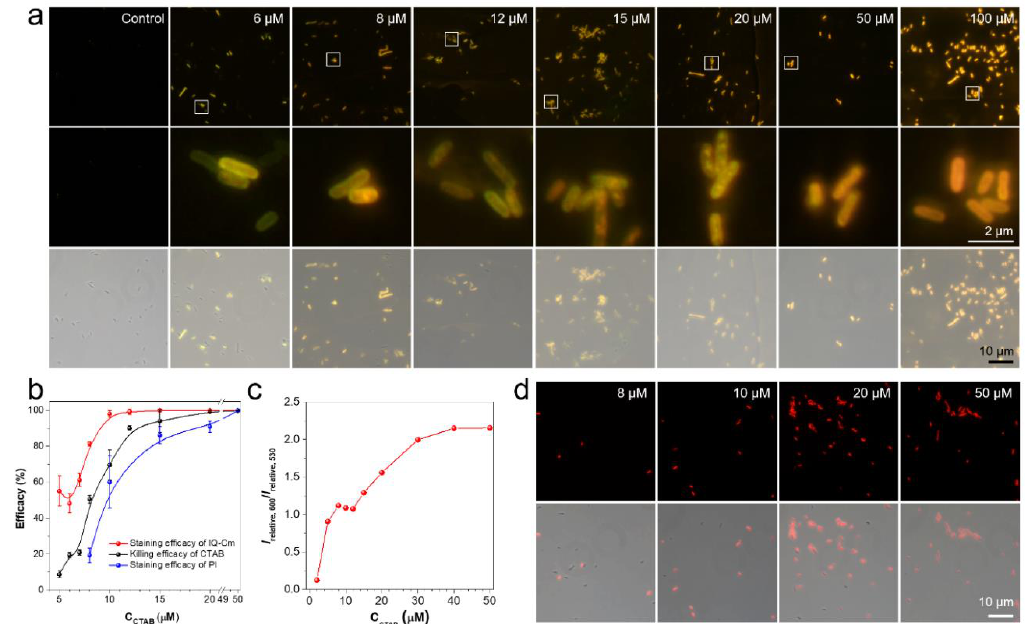
Figure 3. Visualization of the activity of antimicrobials under different concentrations. ( a ) Fluores- cence images and merged images of E. coli treated by different concentrations of CTAB for 30 min and then stained by 10 µ M of IQ-Cm for 10 min (The second row of images are the enlarged images of chosen white square areas in the first row of images). Excitation filter = 460–490 nm, dichroic mirror = 505 nm, emission filter = 515 nm long pass. ( b ) The plots of the staining efficacy of IQ-Cm and PI for E. coli and the antibacterial activity of CTAB against E. coli versus the concentration of CTAB. ( c ) The plots of the ratio of emission intensities at 600 nm and at 530 nm of IQ-Cm in the presence of E. coli treated with different concentrations of CTAB (The data obtained from Figure 2a). ( d ) Fluorescence and merged images of E. coli treated with CTAB for 30 min and then stained with 5 µ g/mL of PI for 10